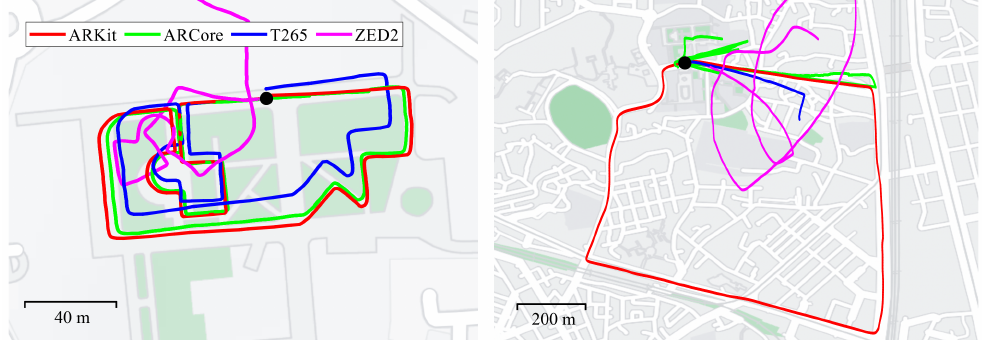
Figure 8. Estimated motion trajectories of four proprietary VIO systems in the outdoor campus ( left ) and urban outdoor roads ( right ) sequences overlaid on Google Maps. We started and ended at the same point, which is marked in the black circle, to check the loop-closing performance. ARKit (red) tracked the 6-DoF camera poses well, following the shape of the roads on Google Maps most consistently and accurately. Only ARKit (red) was able to produce stable motion-tracking performance even when driving a vehicle over 60 km/h ( right